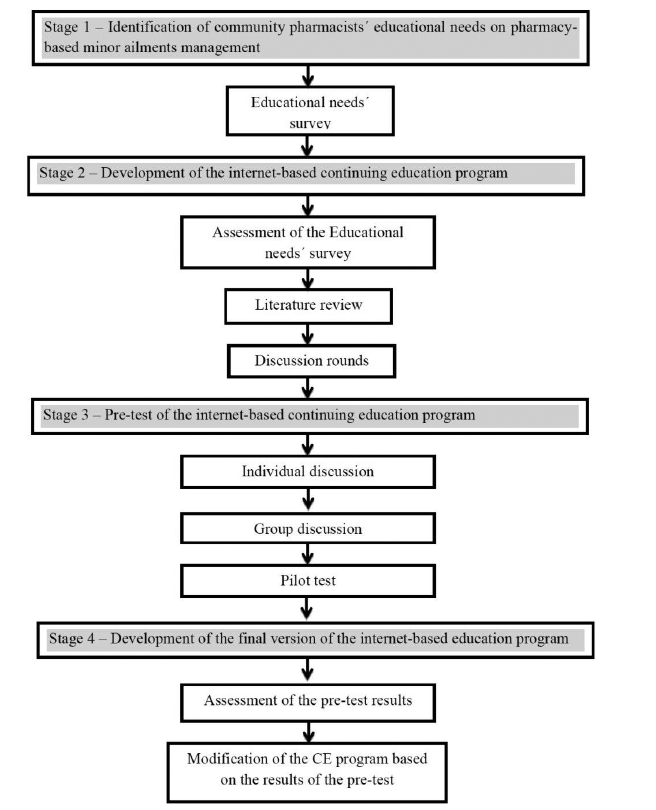
FIGURE 1 - Overview of stages in creating an internet-based continuing education program on pharmacy-based minor ailments